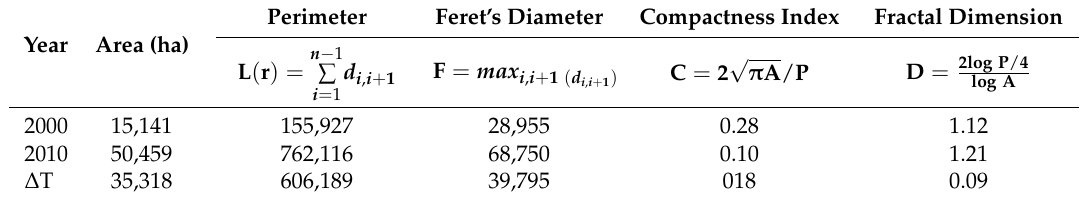
Table 3. Urban compactness metrics based on land-use mapping.